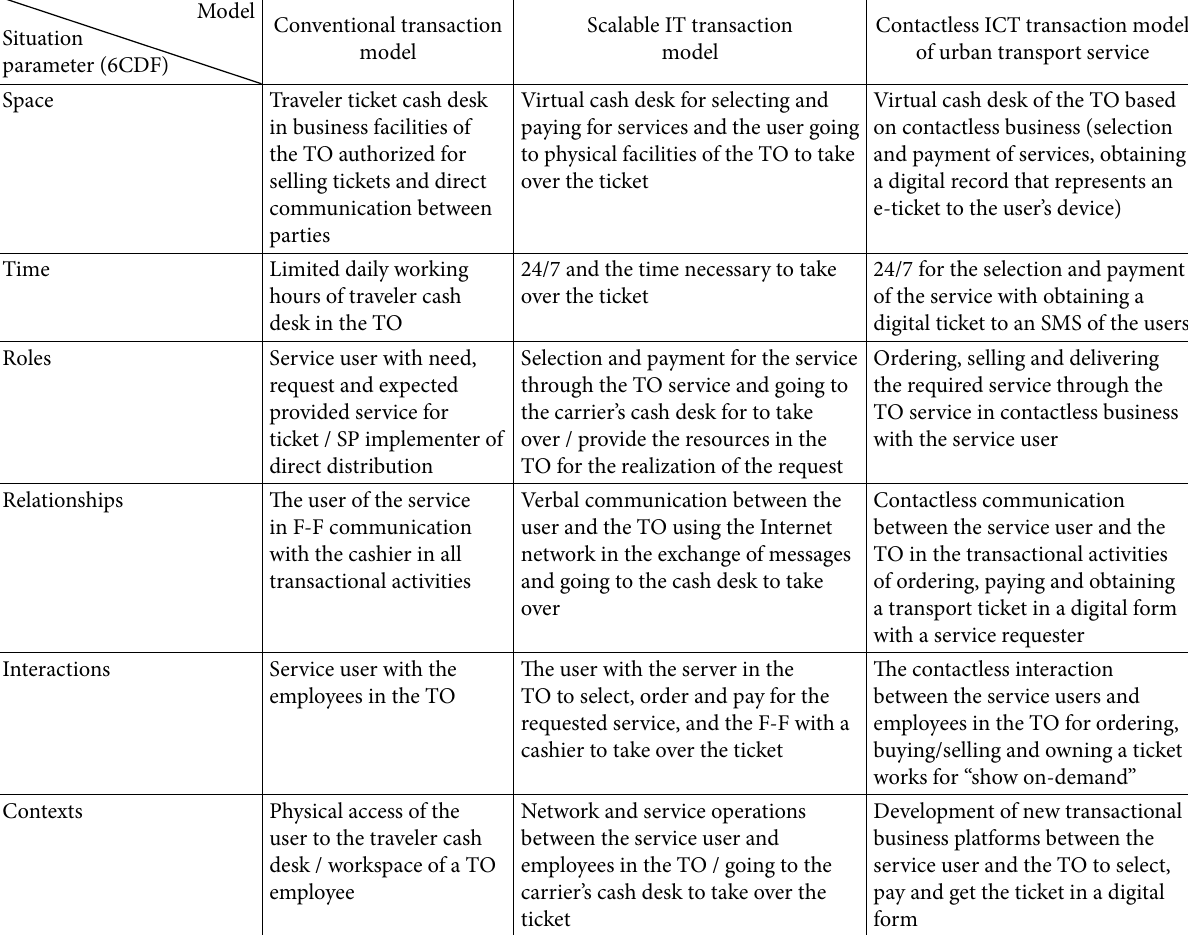
Table 2. Comparative view of the factors of the communication dynamics of the conventional, scalable IT and innovative contactless ICT transaction model of urban transport service (adapted according to Banjanin (2008a,